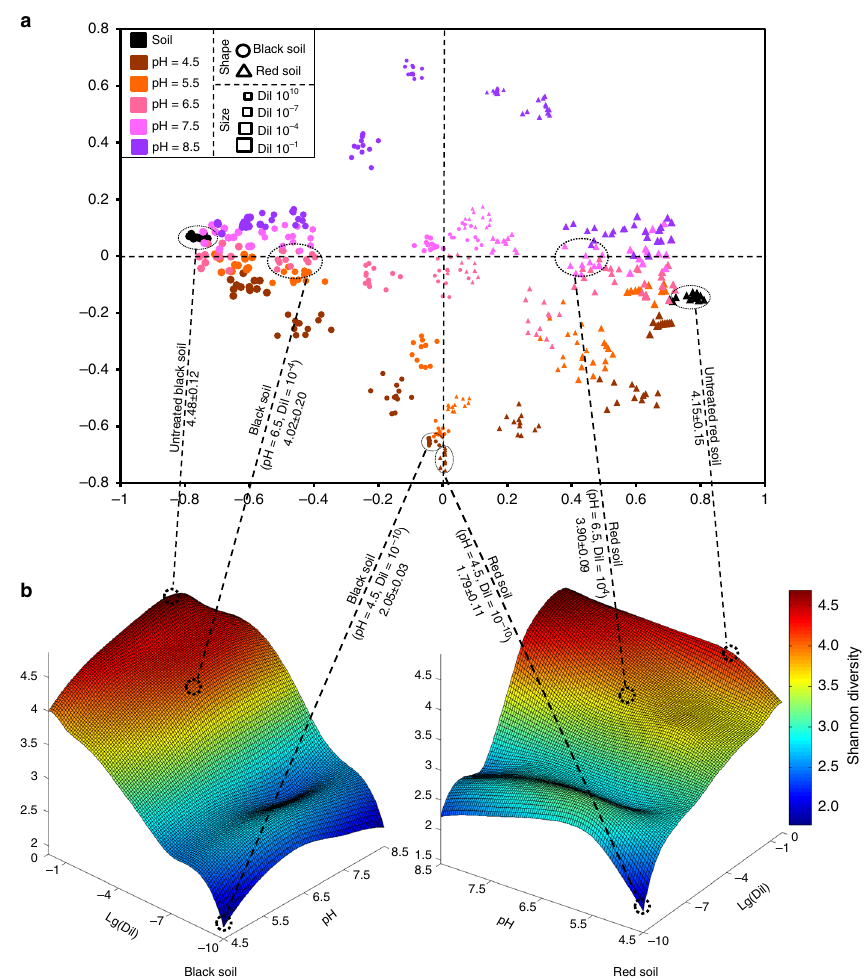
Fig. 1 Dimension reduction analysis and Shannon diversity of re-assembled bacterial communities. a Non-metric multidimensional scaling (NMDS) analysis of all incubated soil samples based on the Bray – Curtis taxonomic similarity. b The variances of Shannon diversity indices across soil pH and dilution gradients for black (left) and red (right) soils. Selected samples and corresponding diversity indices are connected by dotted lines. Lg(Dil) indicates the Lg- transformed dilution level. Lg(Dil) = 0 represents the untreated